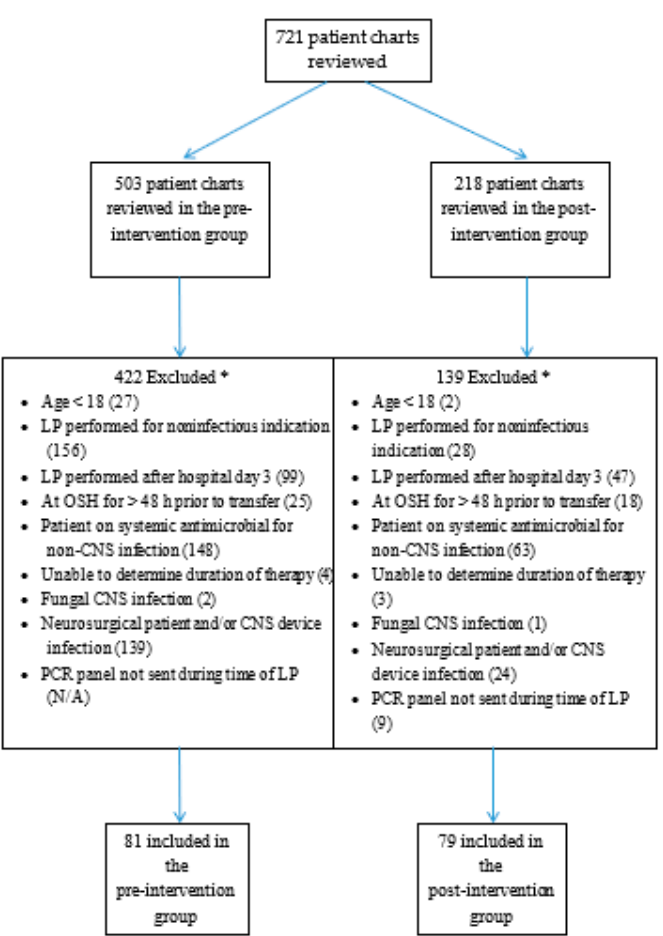
Figure 1. Patient Screening. * Multiple exclusion criteria could be applied to each patient. Abbreviations: LP: Lumbar puncture, OSH: Outside hospital, CNS: Central nervous system, PCR: Polymerase chain reaction.